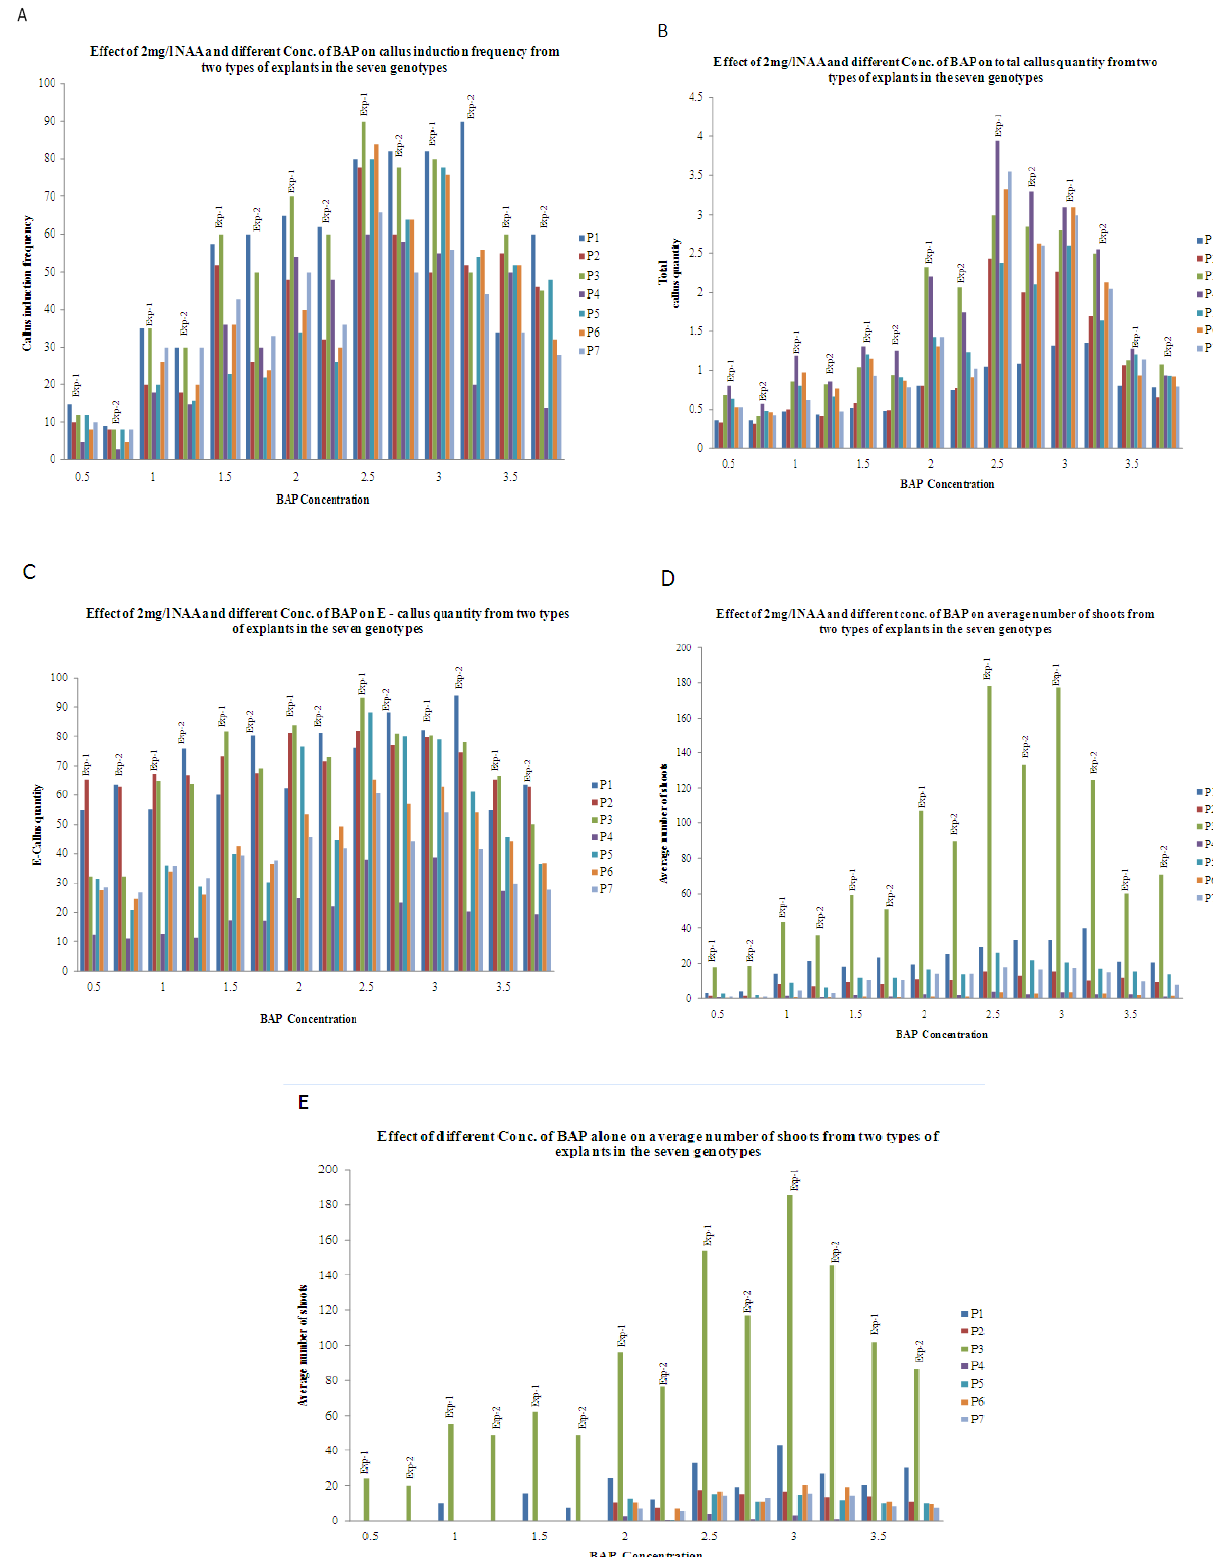
Fig. 2. Graphs for In vitro response of two types of explants of seven Solanum genotypes: A) callus initiation; B) callus quantity; C) E-callus quantity; D) Avg. Number of shoots in MSKB; E) Avg. Number of shoots in